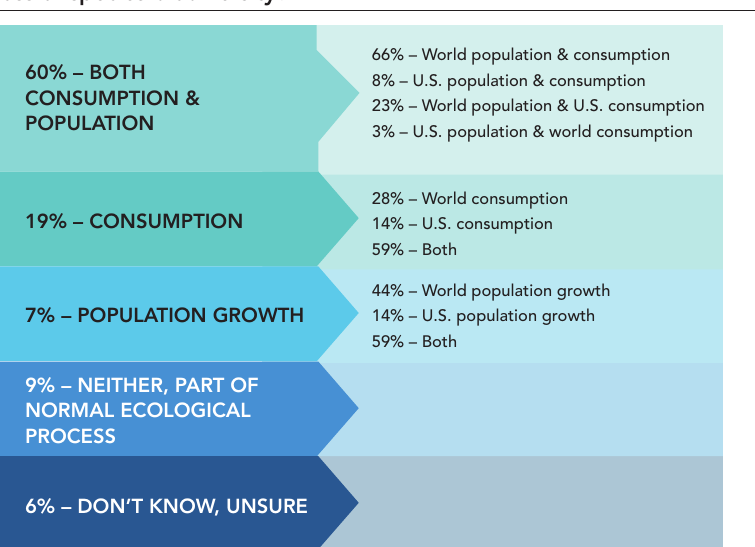
Figure 1: Attitudes: What do you think is primarily responsible for the rapid loss of species